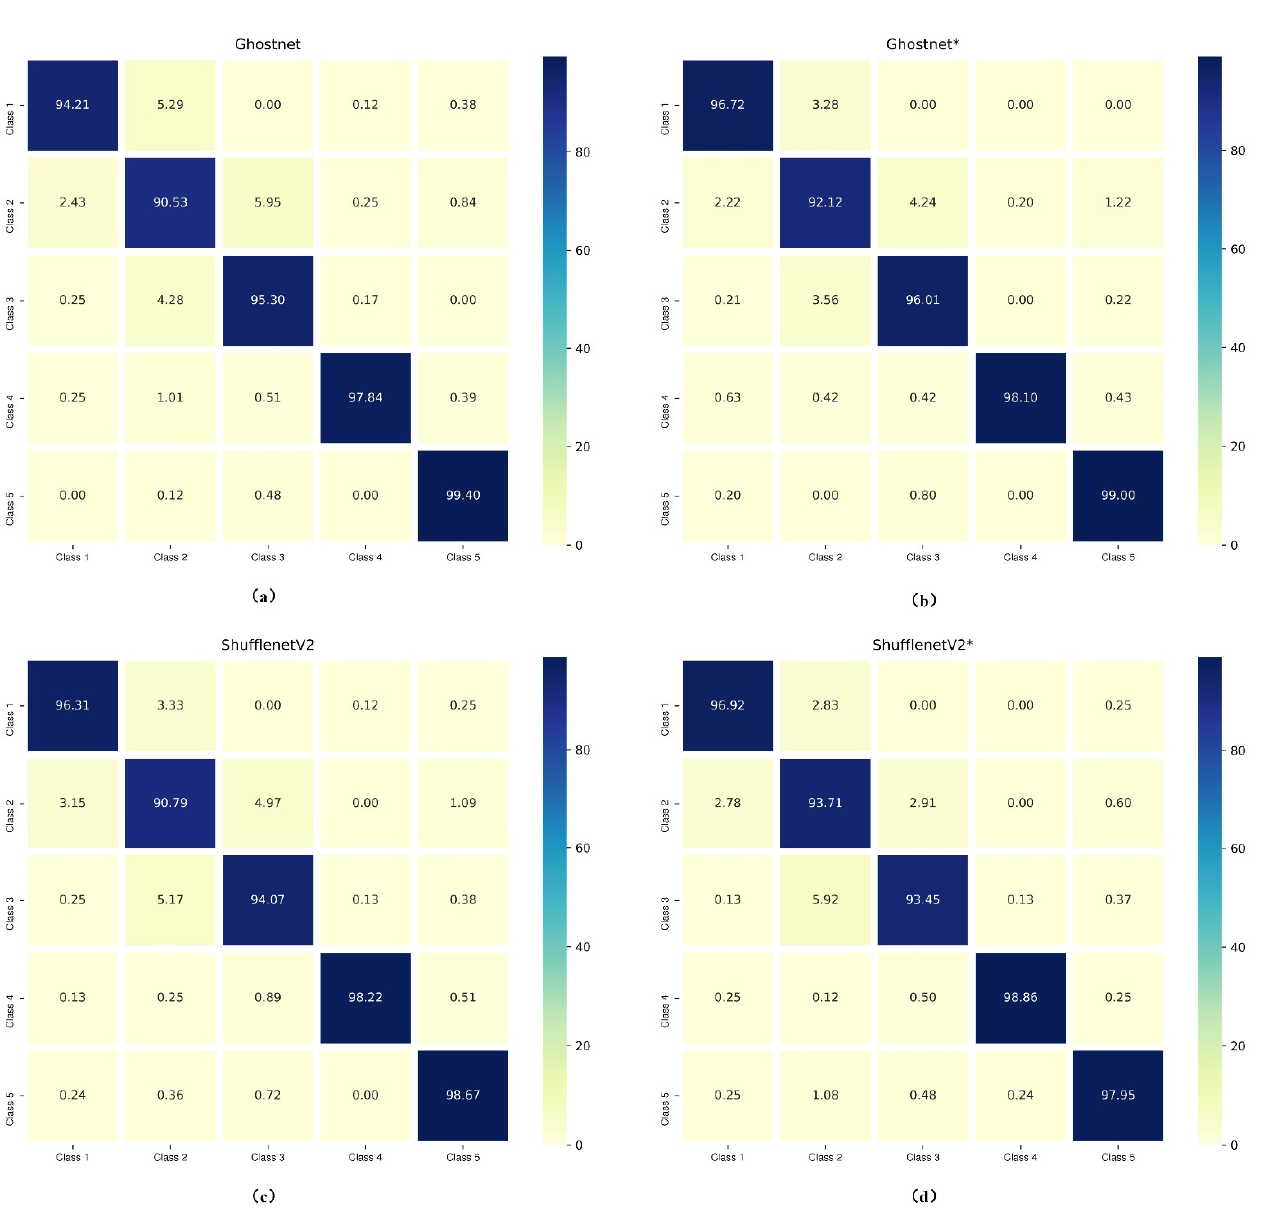
Figure 3. Confusion matrixes of Ghostnet and ShufflenetV2 trained with and without hybrid loss (“*” means the CNN model was trained with hybrid loss function). Class 1, superficial/intermediate; Class 2, parabasal; Class 3, metaplastic; Class 4, koilocytotic; Class 5, dyskeratotic. ( a ) Ghostnet; ( b ) Ghostnet*; ( c ) ShufflenetV2; ( d )